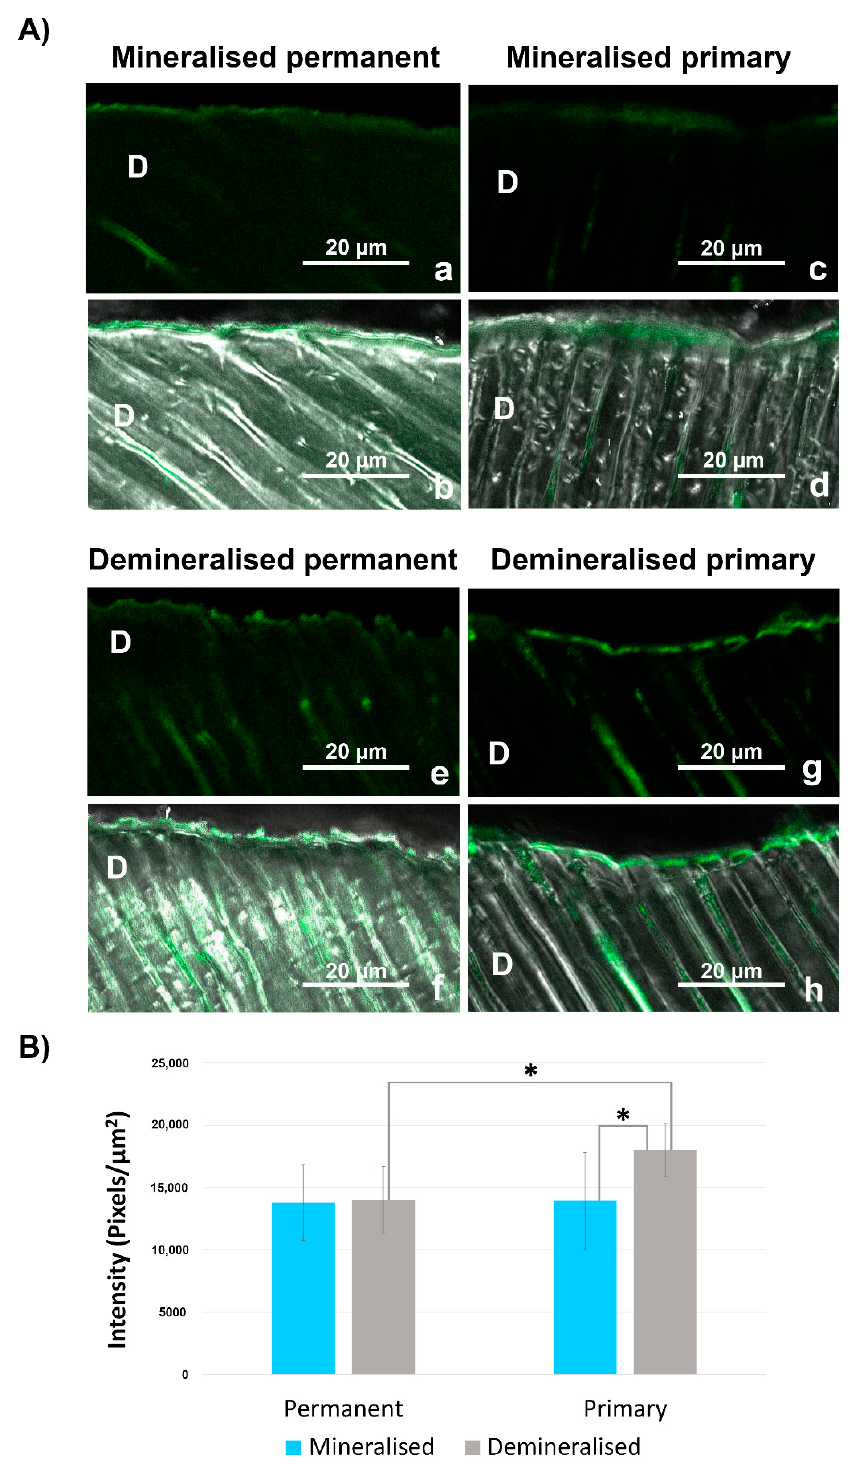
Figure 2. In situ zymography of dentine slices: ( A ) confocal laser scanning microscopy images acquired using the green-channel, showing fluorescence in mineralised and acid-etched permanent and primary dentine ( a , c , e , g ); Confocal laser scanning microscopy images of different groups obtained by merging differential interference contrast images (showing the optical density of dentine) and images acquired with the green channel of the same groups ( b , d , f , h ); ( B ) in situ zymography quantification (mean ± standard deviation). Statistically significantly different groups are marked with an asterisk. Asterisk marks groups that are statistically significantly different from each other ( p < 0.05). D—dentine.